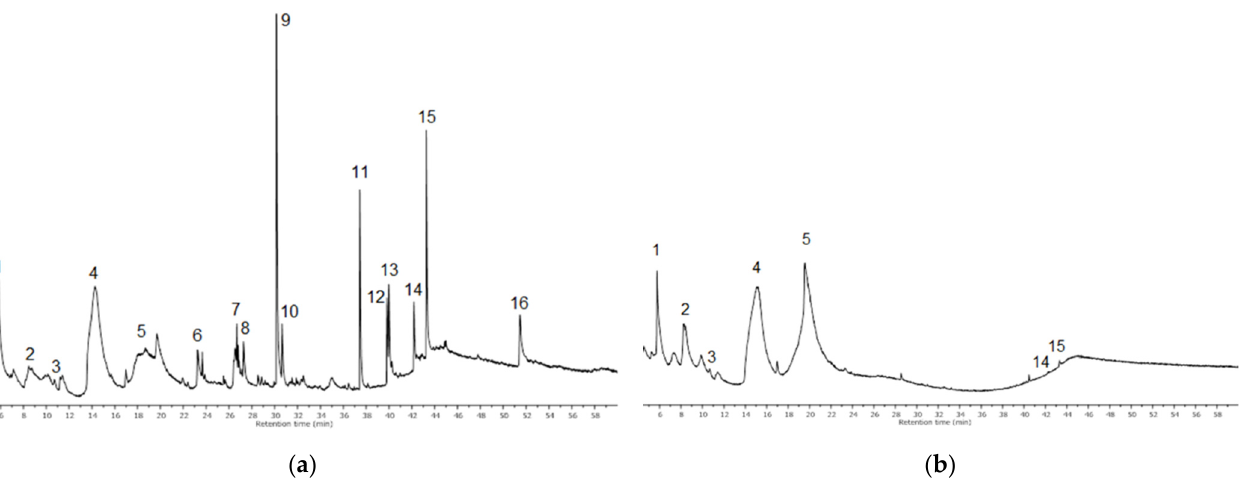
Figure 4. GC-MS chromatograms of ethanolic ( a ) and water ( b ) extracts of maca ( L. meyenii ) root (peaks numbered according to Table 3). Table 3. Compounds identified in ethanolic (E) and water (W) extracts of maca ( L. meyenii ) root extracts by the GC-MS